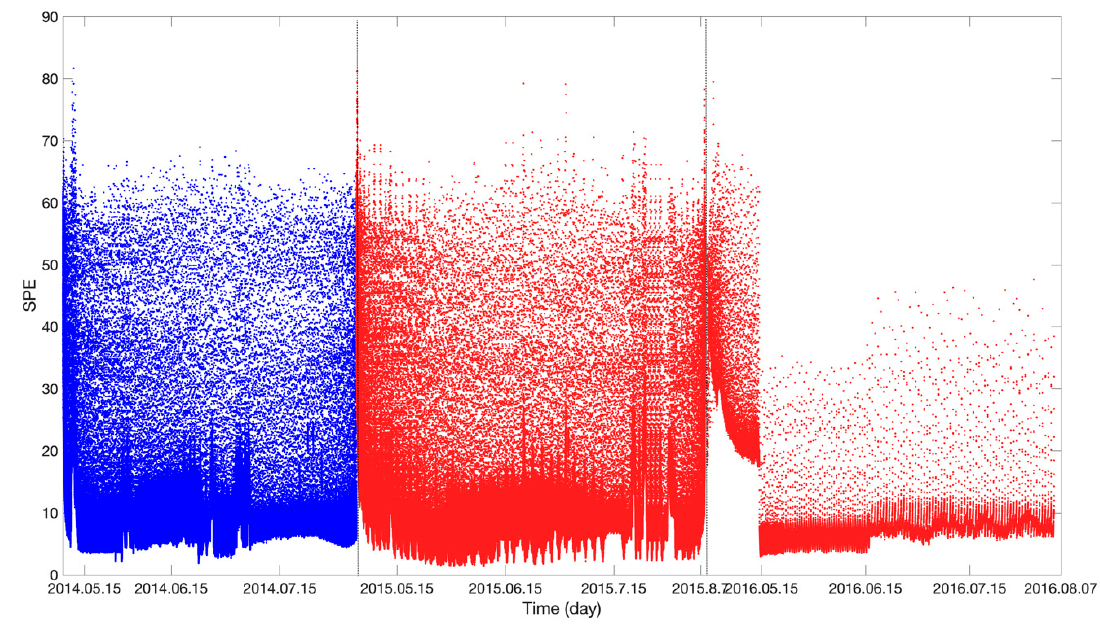
Figure 10. Locally linear embedding (LLE) algorithm anomaly-detection result (SPE).